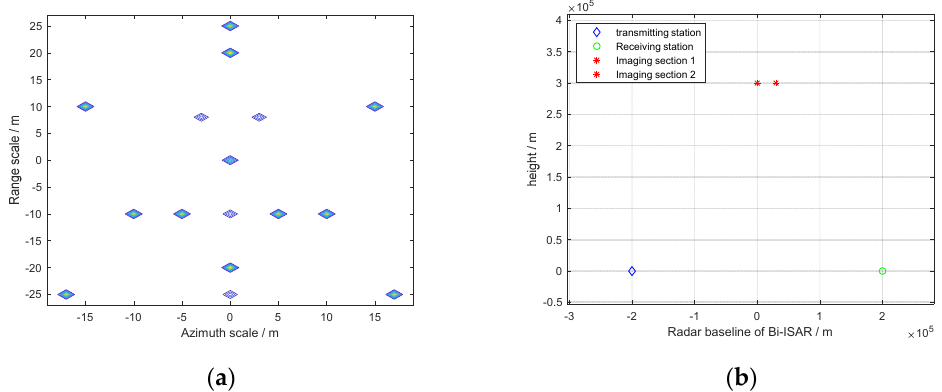
Figure 5. Simulation conditions: ( a ) scattering points model; and ( b ) Bi − ISAR simulation scenario. Table 1. Simulation experiment